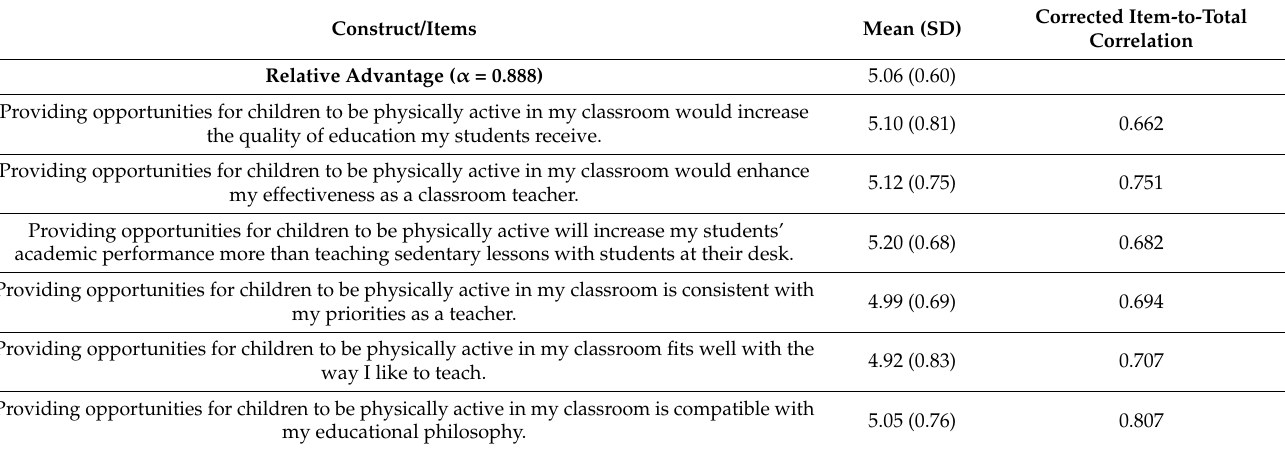
Table 2. Survey Constructs/Scales/Items, with Response Descriptive Data and Item-to-total correla- tions within